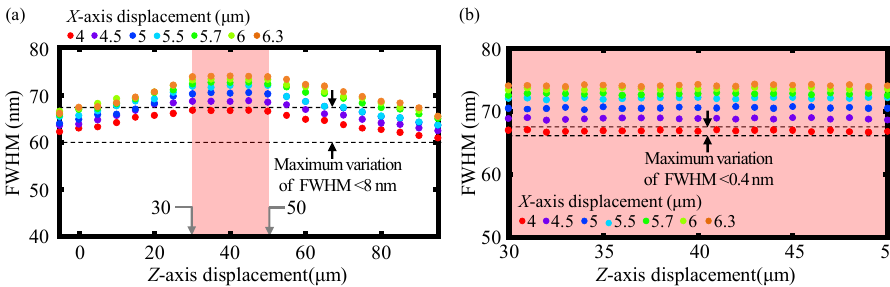
Figure 5. Simulation results of ( a ) the variation of FWHM within Z -axis displacement ranging from −5 to 95 μm; and ( b ) the corresponding Z -axis displacement ranging from 30 μm to 50 μm at the X - axis displacements from 4 μm to 6.3 μm.